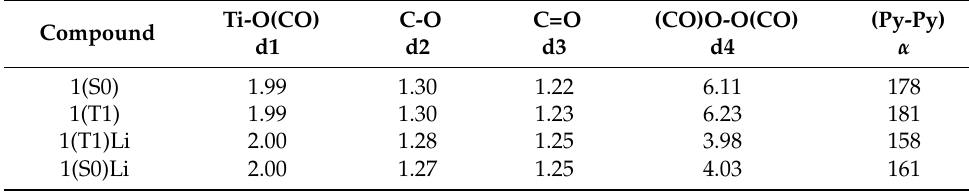
Table 6. Atomic distances (A) and bond angles ( ◦ ) for the lithium adduct.